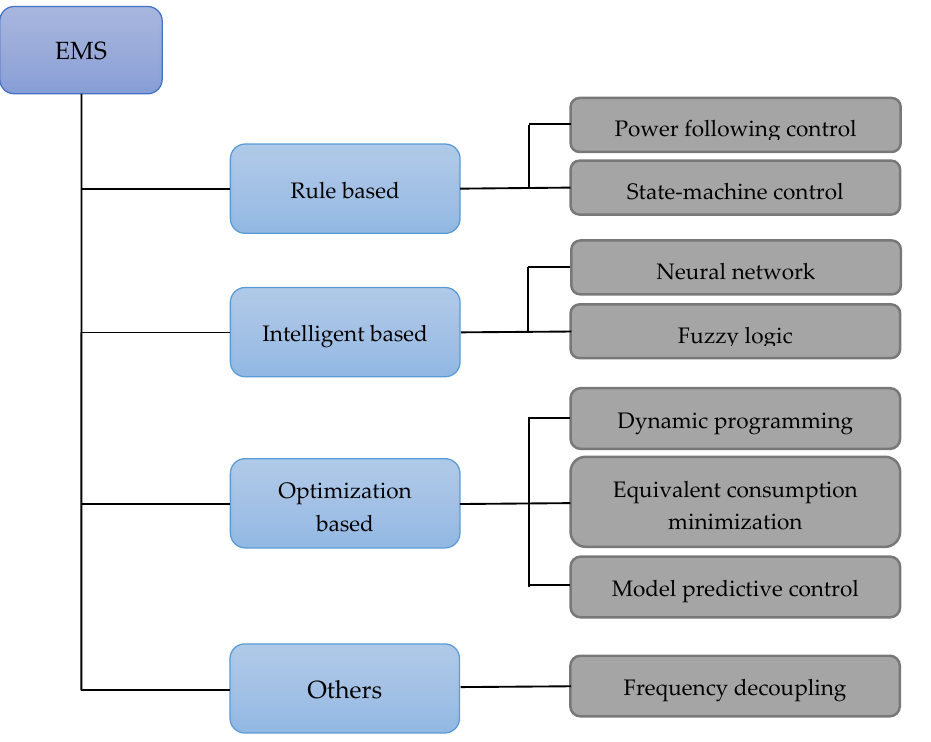
Figure 7. EMS classification for UAVs.